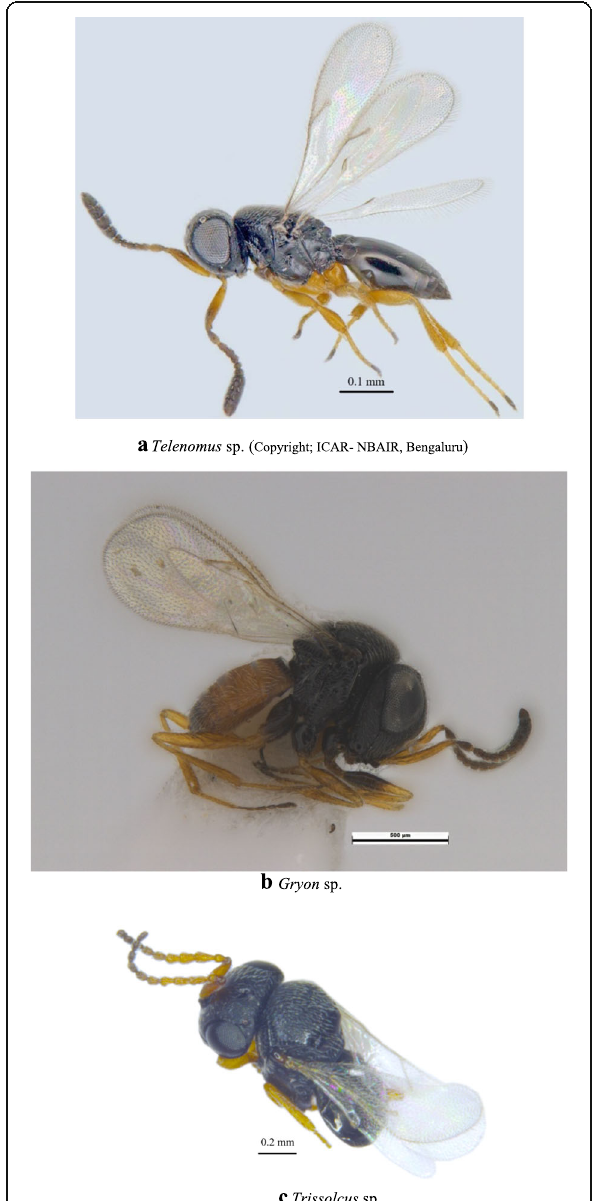
Fig. 3 a Telenomus sp. (copyright; ICAR-NBAIR, Bengaluru). b Gryon sp. c Trissolcus